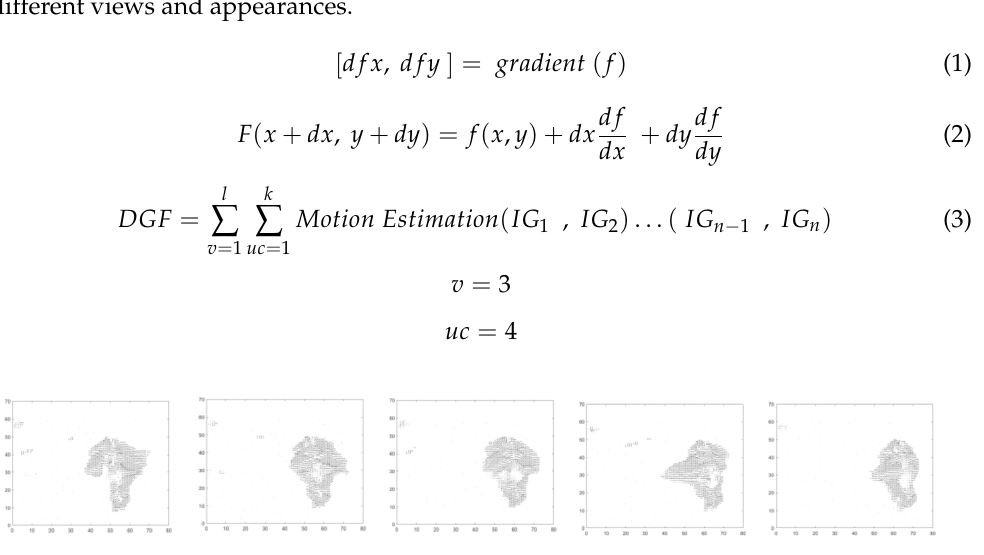
Figure 3. DGF Extraction for Consecutive Steps of Gait Cycle